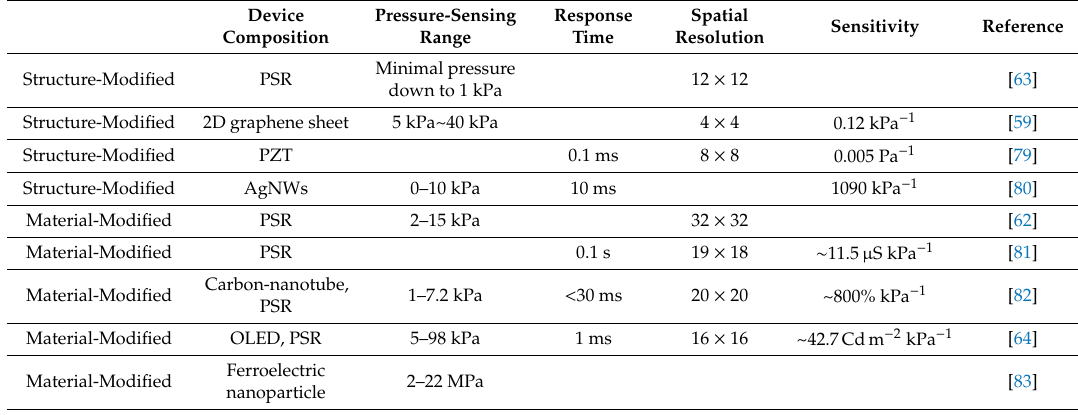
Table 1. Comparison of active-matrix transistor array device for tactile pressure